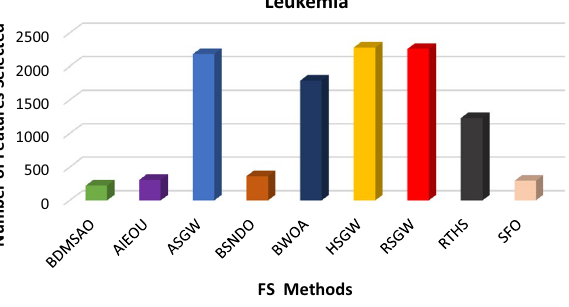
Figure 11. The number of features selected by BDMSAO and other FS methods on Leukemia.